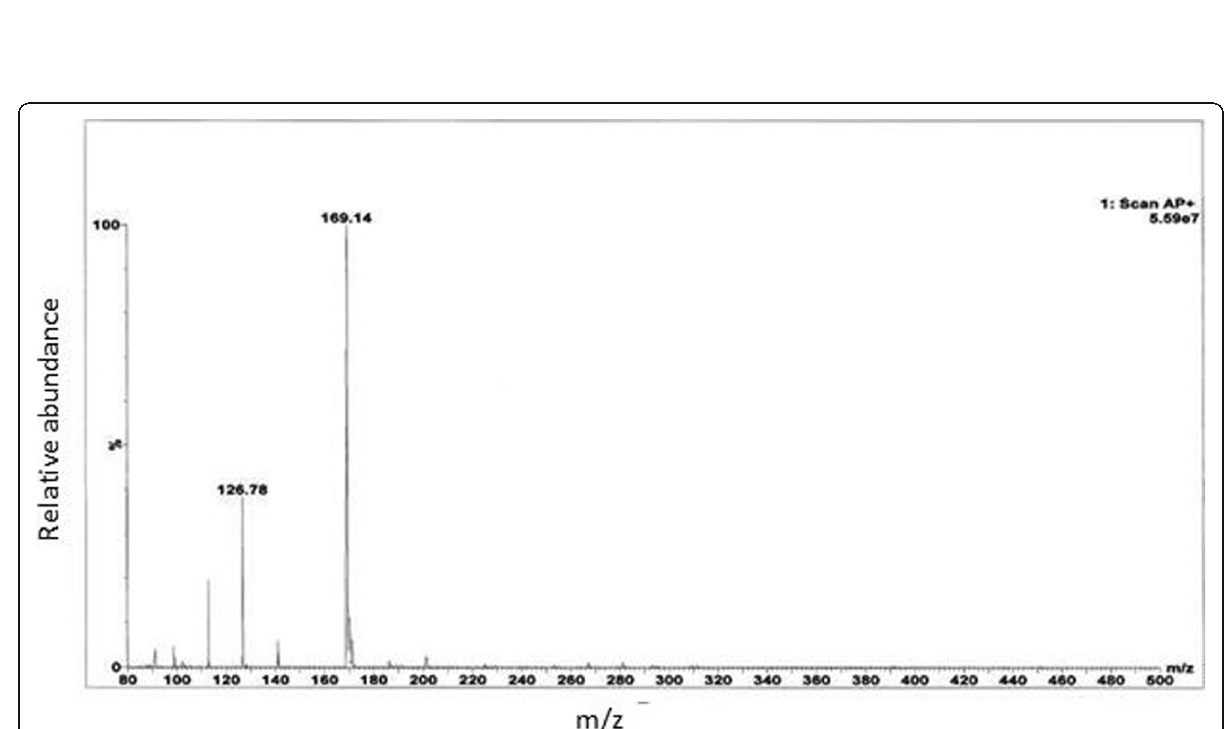
Fig. 3 Mass spectrum of phenyl vinyl